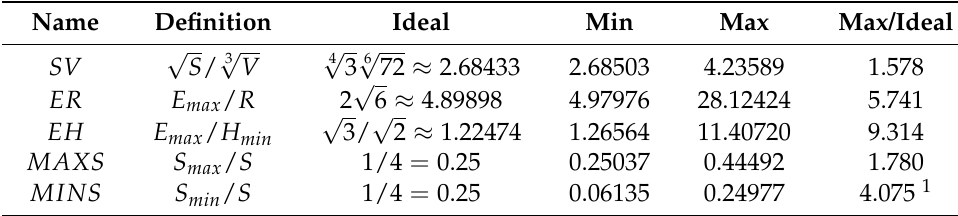
Table 4. Mesh quality of the globe 3D model.